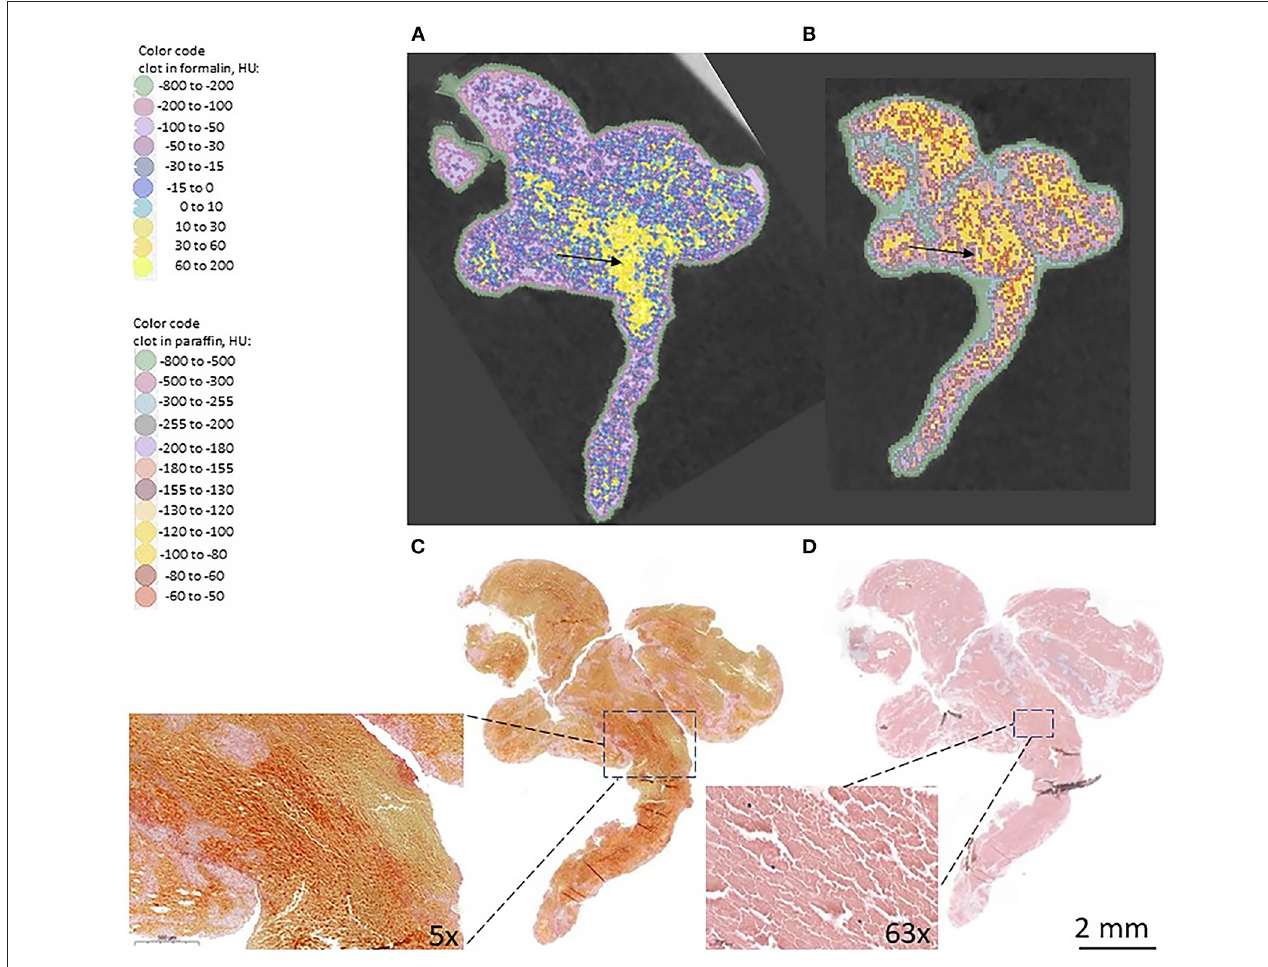
FIGURE 3 | Comparison microCT and histological staining: (A) microCT slice of formalin-fixed clot; (B) microCT slice of clot embedded in paraffin; (C) Histological staining of the clot with Martius Scarlet Blue (MSB), in which RBCs appear yellow and fibrin appears red; (D) Histological staining of the clot with hematoxylin and eosin (HE). In the inset: RBCs rich